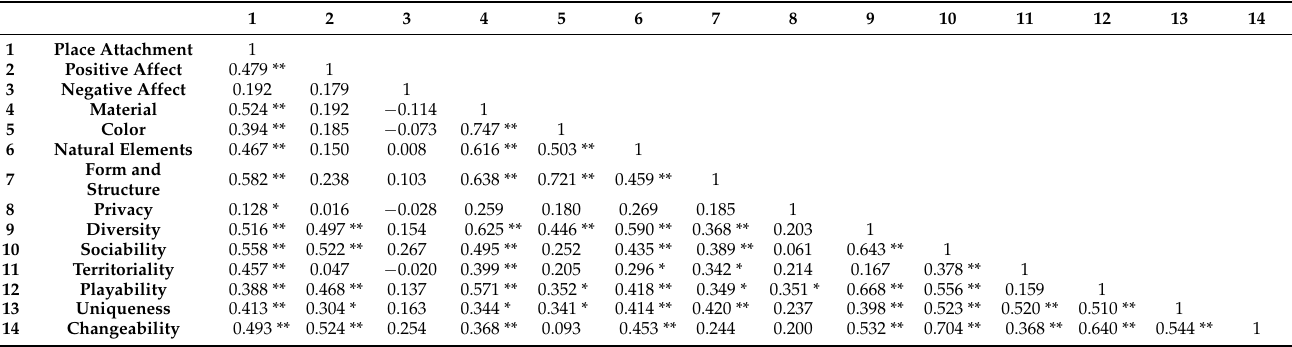
Table 6. Correlation coefficients between different attachment indicators of Beijing Road.